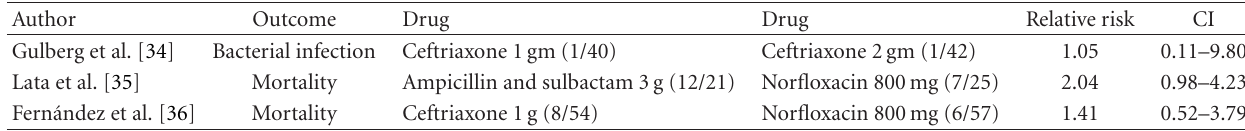
Table 2: Antibiotics preventing mortality in acute variceal